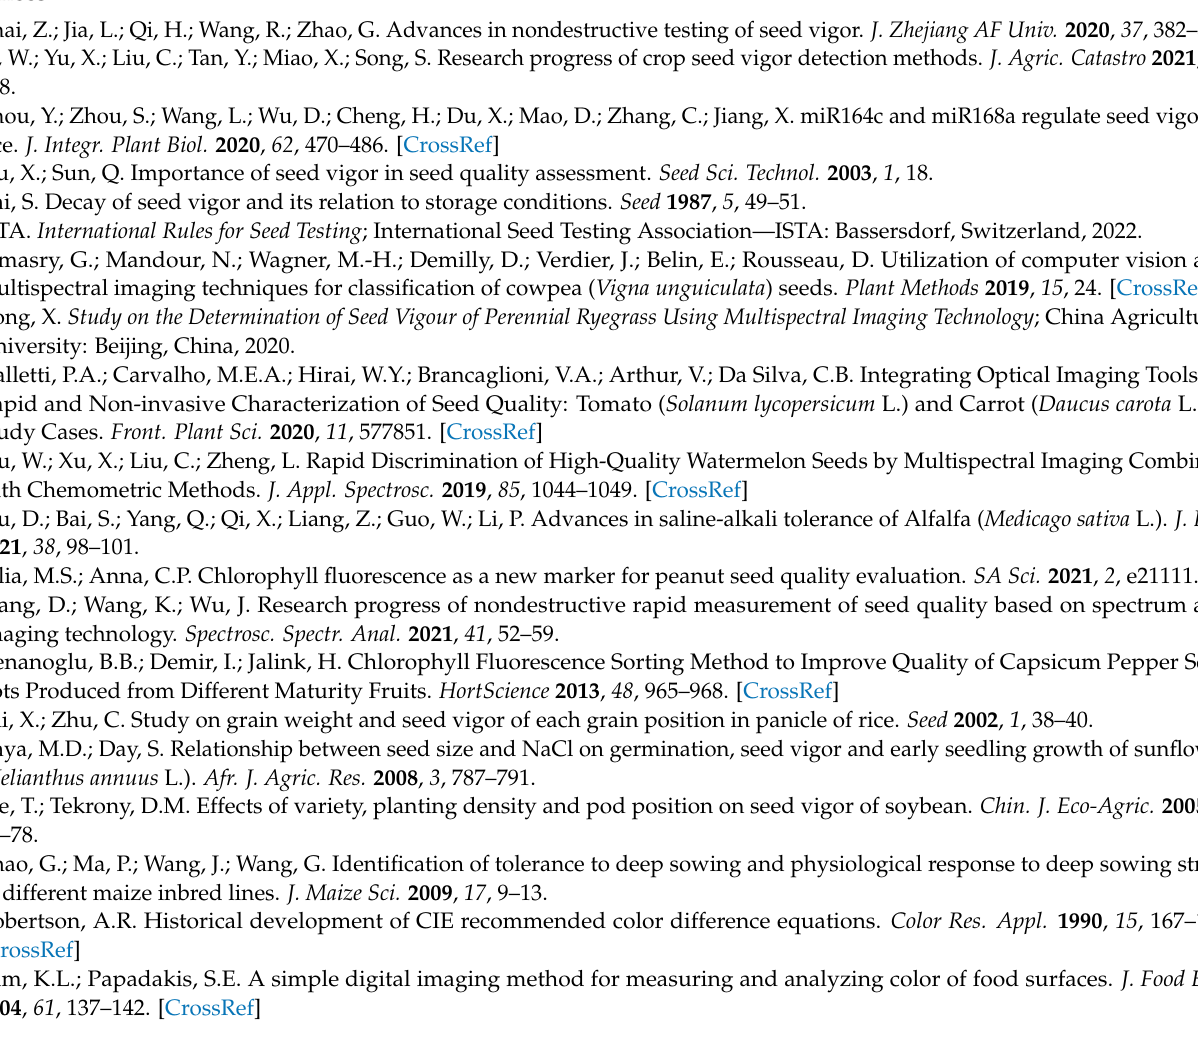
19 wavelengths in all seeds, Table S2: Data of morphological feature in all seeds. Figure S1: Multi- spectral image of seeds harvested in 2004. Figure S2: Multispectral image of seeds harvested in 2008. Figure S3: Multispectral image of seeds harvested in 2019. Figure S4: Multispectral image of seeds harvested in green ripe stage. Figure S5: Multispectral image of seeds harvested in yellow ripening stage. Figure S6: Multispectral image of seeds harvested in full ripe